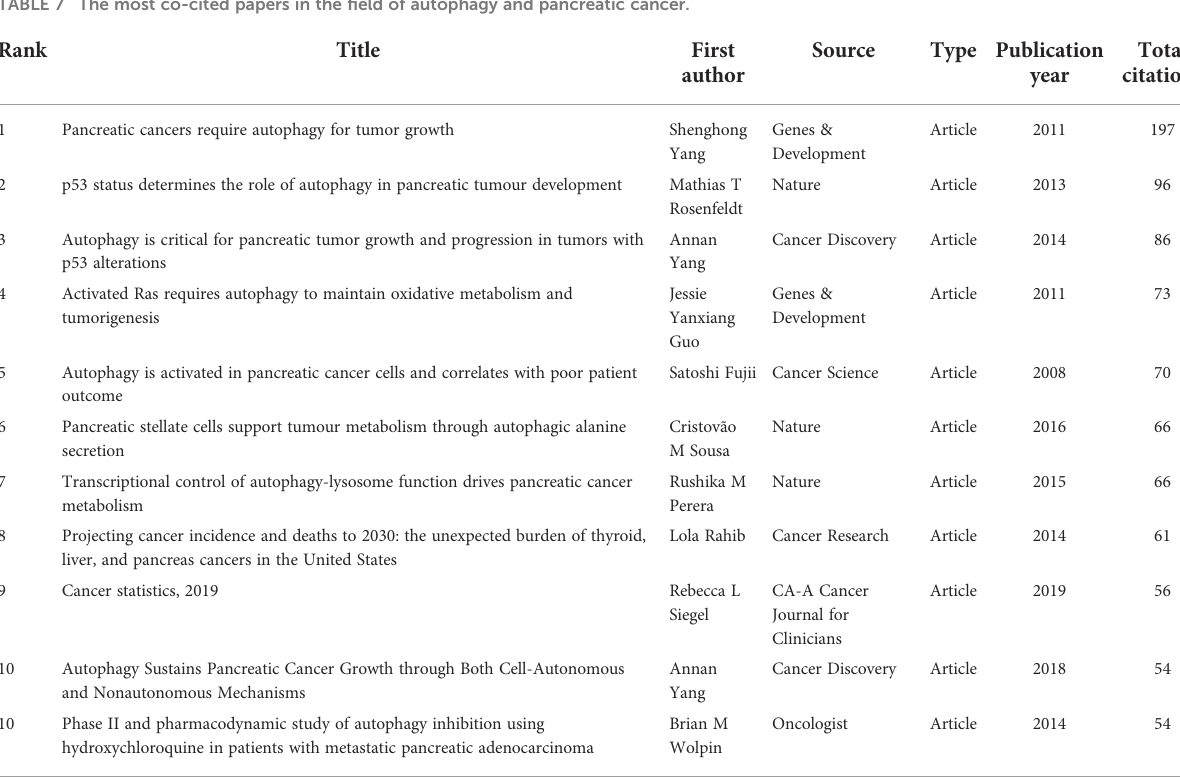
TABLE 7 The most co-cited papers in the fi eld of autophagy and pancreatic cancer. Rank